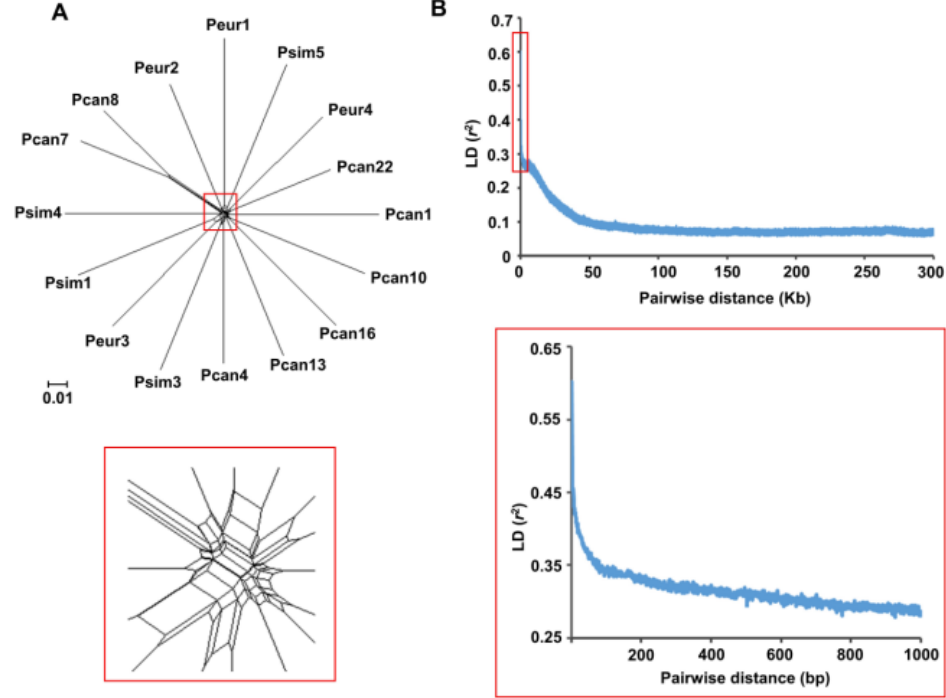
Figure 3. Recombination in the MbMu population. ( A ) Neighbor-net phylogenetic network of the 16 nonredundant MbMu isolates. Lower panel, local enlargement. ( B ) LD decay in MbMu . The squared correlation coefficient (r 2 ) between pairs of SNP loci was plotted against the physical distance along the genome. Lower panel, local enlargement.